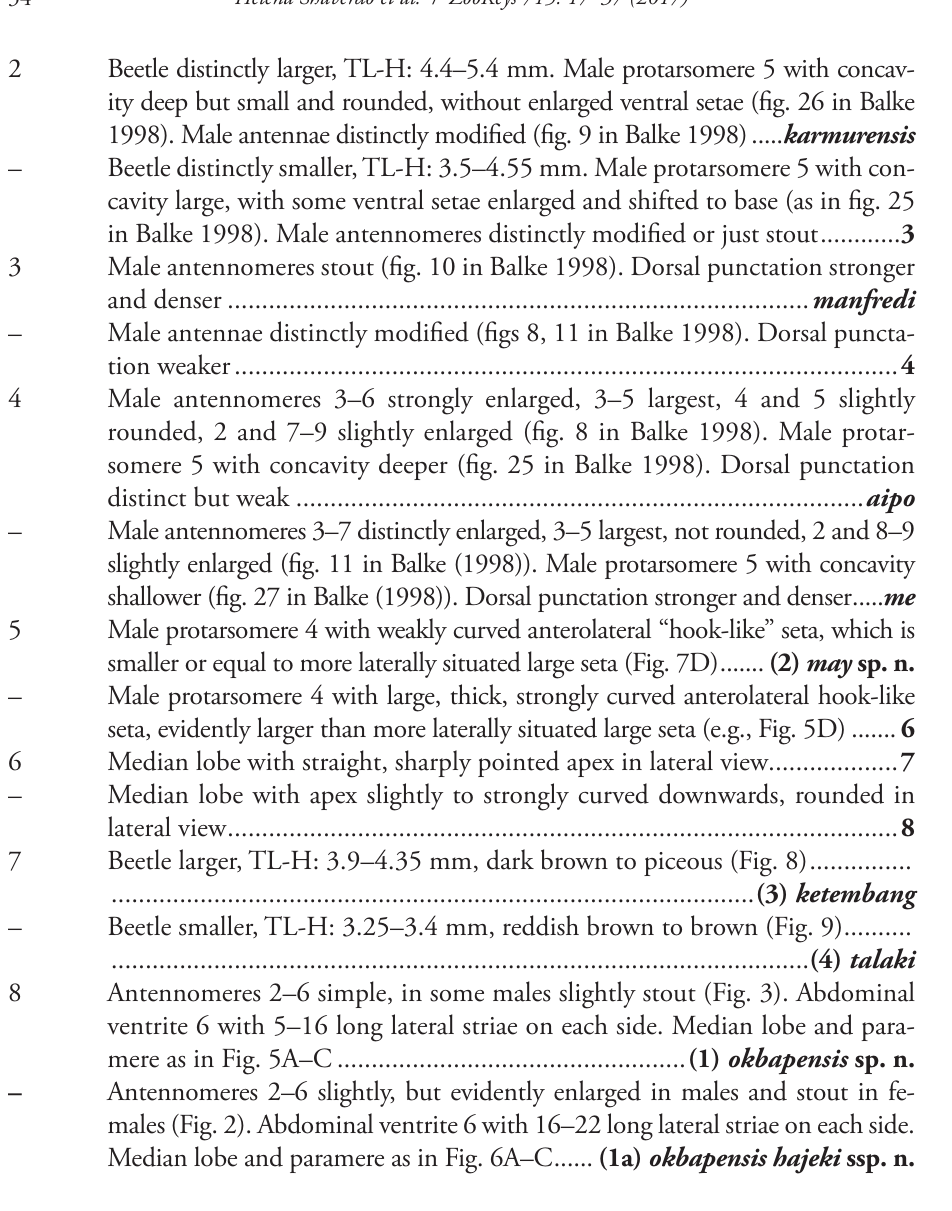
Habitats The studied species have the same habitat preferences as those described in Shaverdo et al. (2012). They are associated with running water, but avoid the current, i.e., their preferred microhabitats are small creeks, small and quiet backflows, puddles at the edge of streams and creeks, and other similar situations (e.g., Figs 13–14). Habitats can be shadowed (in the forest) or sun